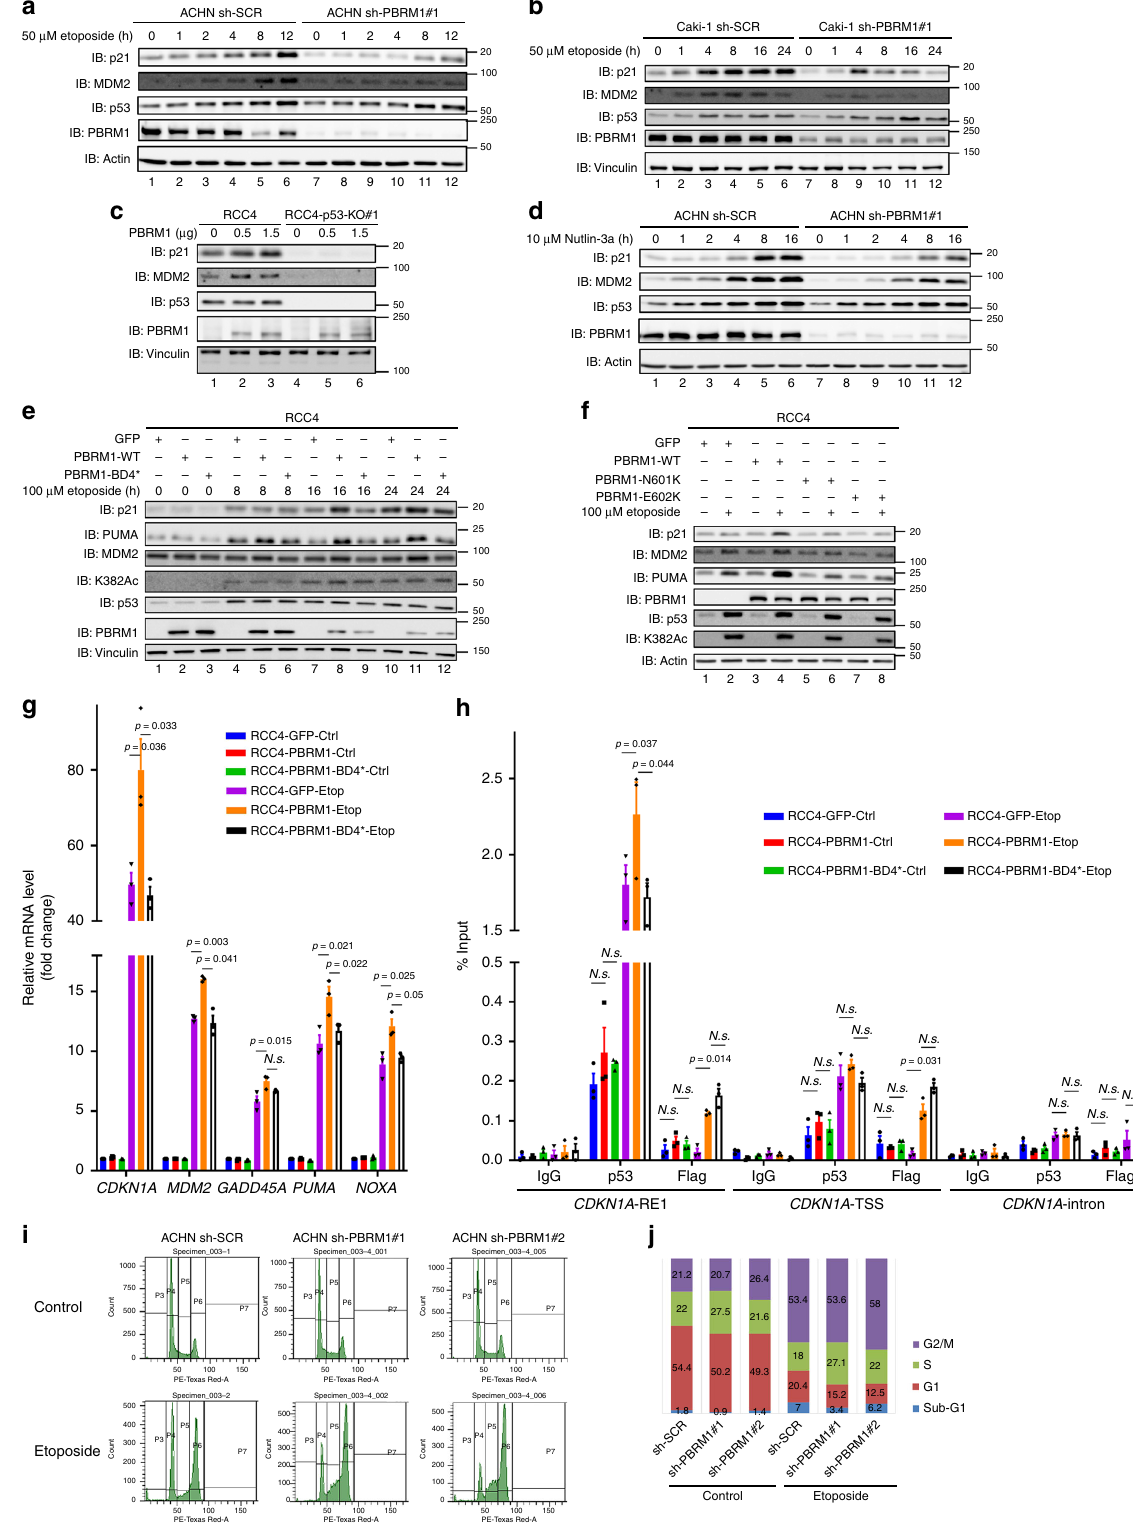
marker (631626, Clontech), p53 Double Nickase Plasmid (h) (sc-416469-NIC, Santa Cruz Biotechnology), or pTetOne construct plus linear puromycin marker using Lipofectamine ™ 2000 (11668019, Thermo Scienti fi c) or X-tremeGENE ™ HP DNA Transfection Reagent (6366546001, Sigma-Aldrich). After 24h, cells were selected with puromycin (2 μ g/ml) for 3 days. Surviving cells were diluted and transferred into 15 cm dishes. After 7 – 10 days, single colonies were isolated.